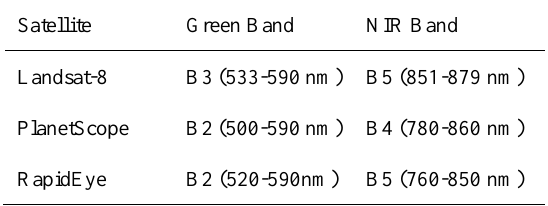
Table 3. Satellite bands utilized in generating the RapidEye and PlanetScope-based VgNIR-BI indices